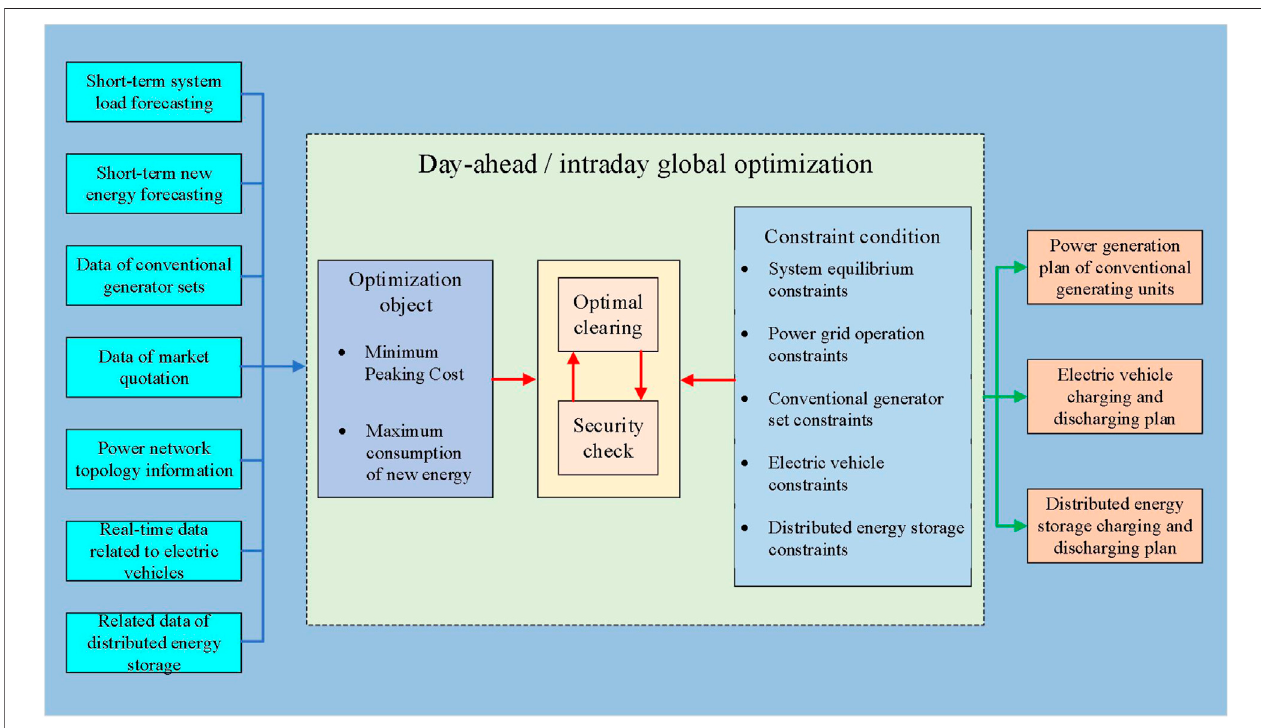
FIGURE 1 | Ideal charge – discharge planning framework for fl exible